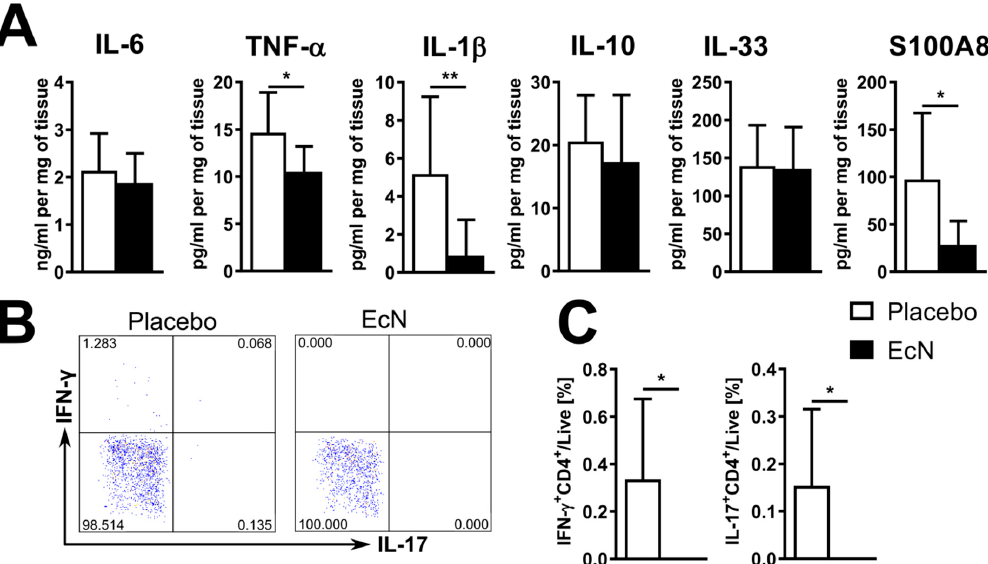
Figure 9. Live oral EcN decreases the production of several pro-inflammatory factors in non-stimulated Peyer’s patches at day 7 post-induction, as measured by ELISA ( n = 9 (placebo) or 8 (EcN)) ( A ). At the same time, live EcN suppressed IFN- γ and IL-17 production by the IRBP-stimulated helper T cells in the inguinal lymph nodes, as shown by the typical dot plot gated on live CD3 + CD4 + cells ( B ) and statistics from 8 (placebo) or 3 (EcN) mice as measured by flow cytometry ( C ). Differences were quantified by unpaired Mann–Whitney test; * p < 0.05, ** p < 0.01.